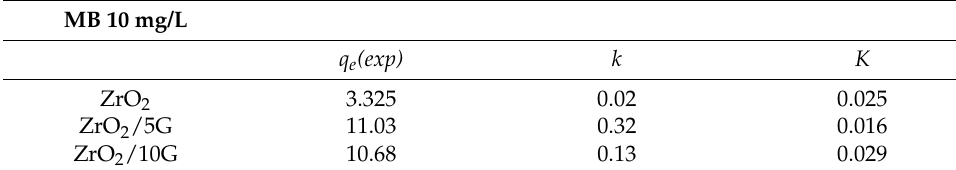
Figure 7. Semi-logarithmic graph of methylene blue (MB) concentration vs. irradiation time in the presence of ZrO 2 , ZrO 2 /G5, and ZrO 2 /G10 for both concentrations of MB of: ( a ) 5 and ( b ) 10 mg/L.